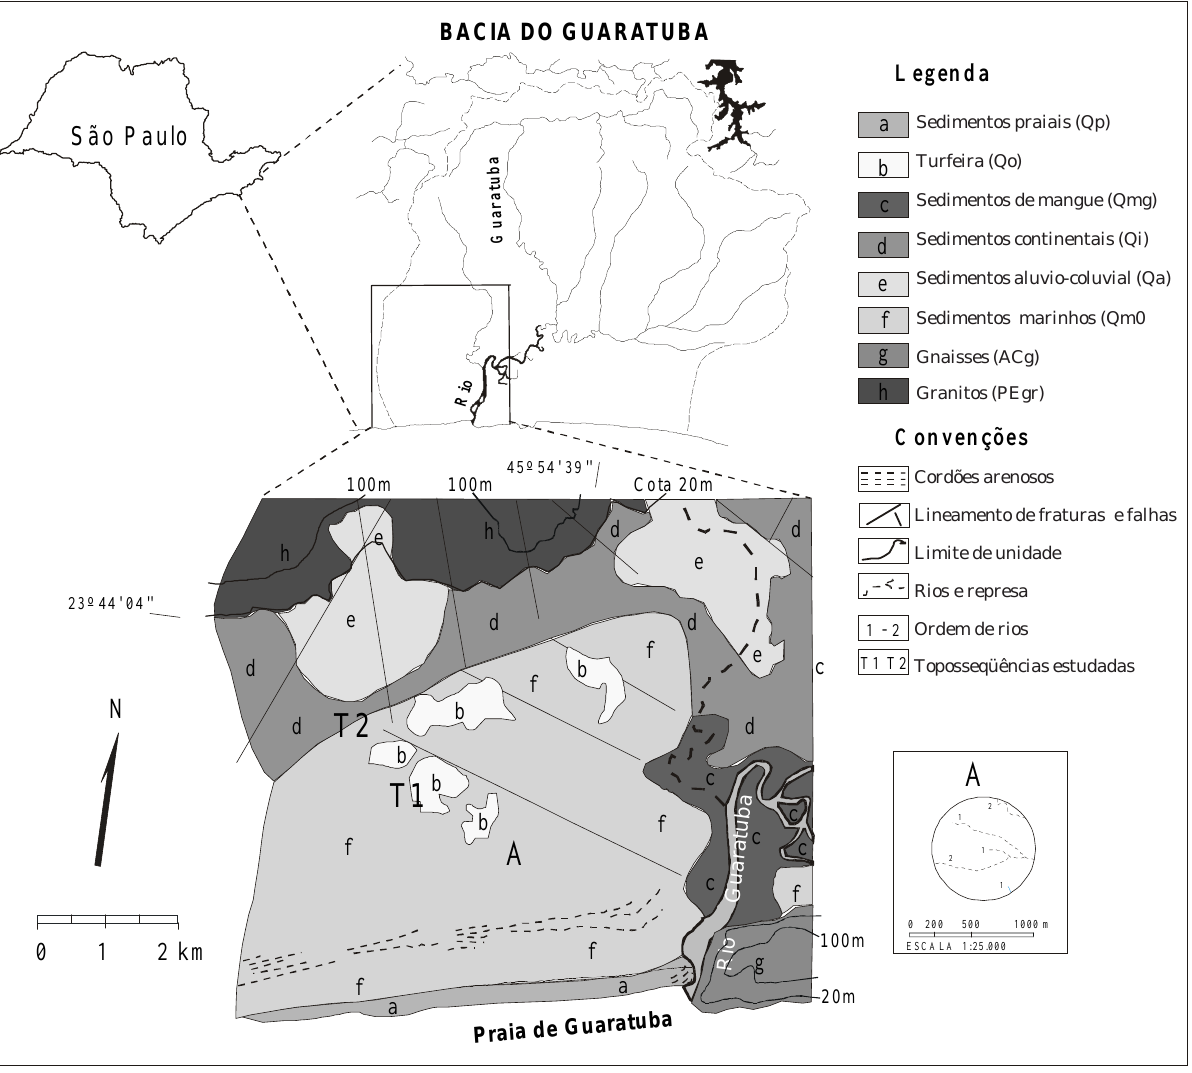
Figura 1. Mapa de localização e da geologia da Bacia do Guaratuba, São Paulo. Fonte Rossi & Queiroz Neto